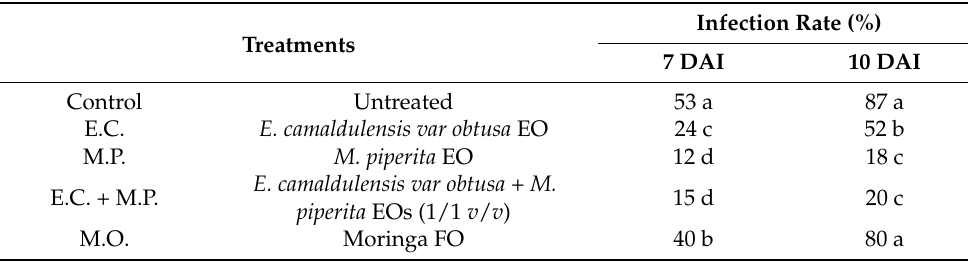
Table 7. Infection rate (%) of strawberry fruits caused by Botrytis cinerea after treatment with differ- ent